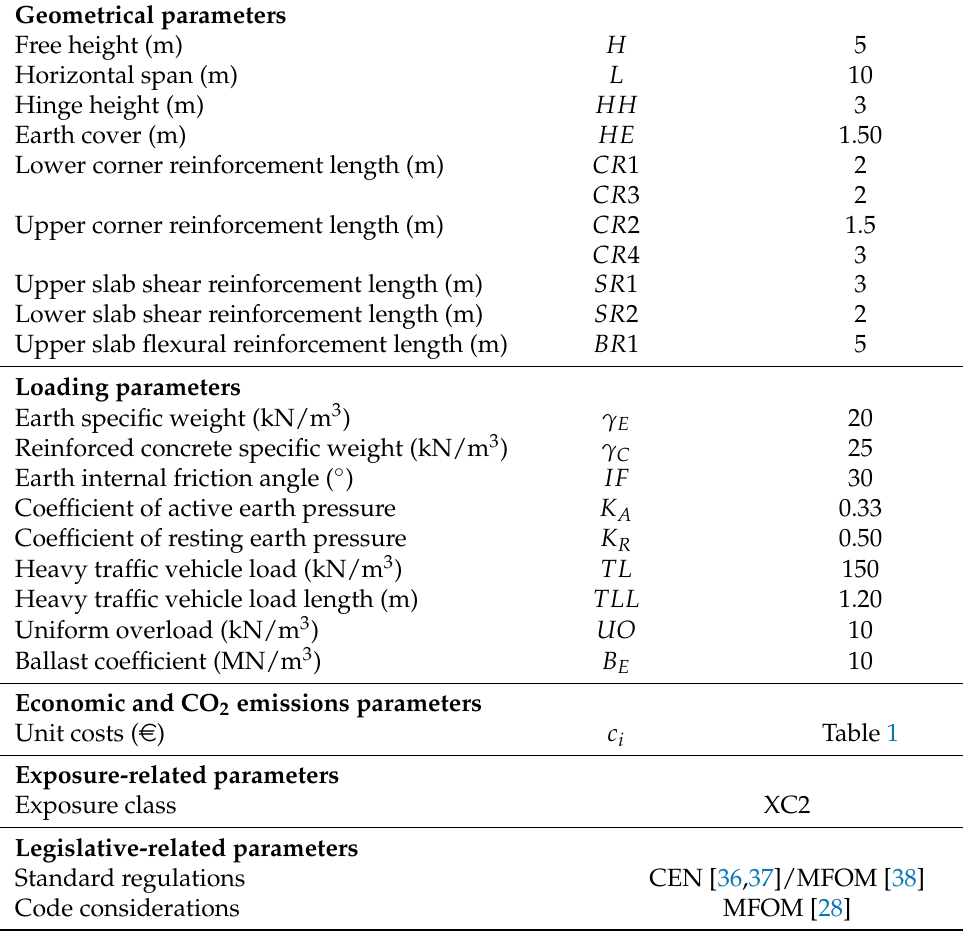
Table 2. Main parameters considered in the RCPHF